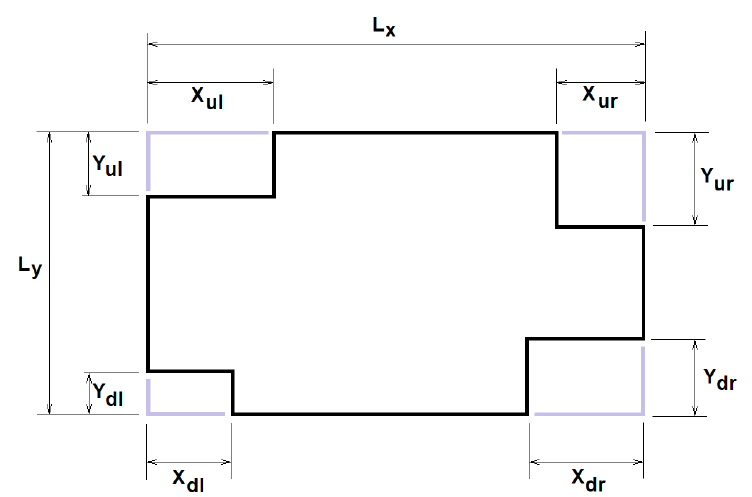
Figure A3. Representation of the generic collector surface Π based on a rectangle with sides L X and L Y with the vertices cut off.